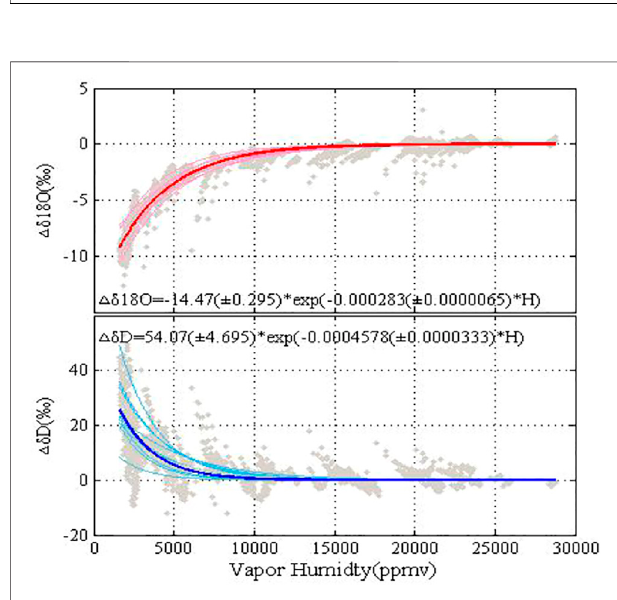
Frontiers in Earth Science |